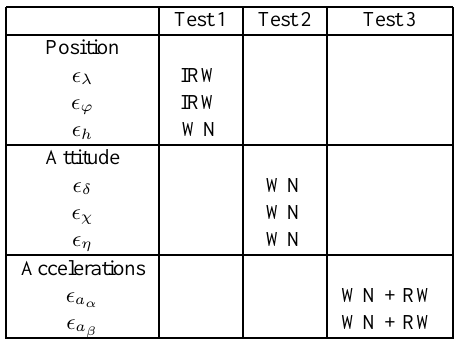
Table 1: Noise models associated to the numerical simulations. IRW stands for Integrated Random Walk, RW for Random Walk and WN for White Noise.